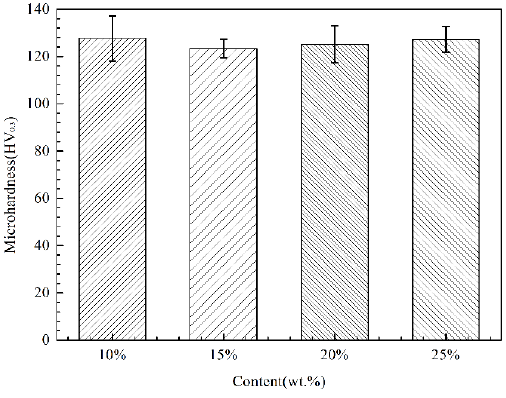
Figure 9. Effect of Ni content on the microhardness of the composite coatings.